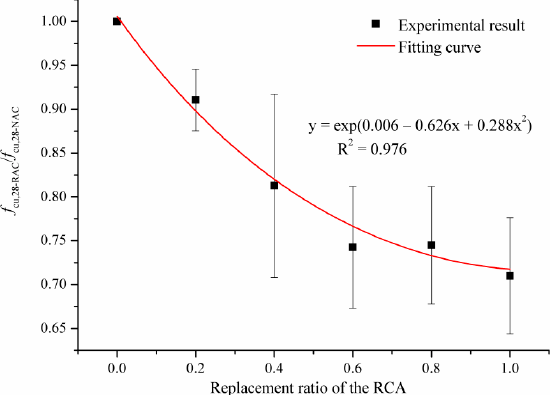
Figure 4. The relative f cu, 28 in dependence on the replacement ratio of RCA.